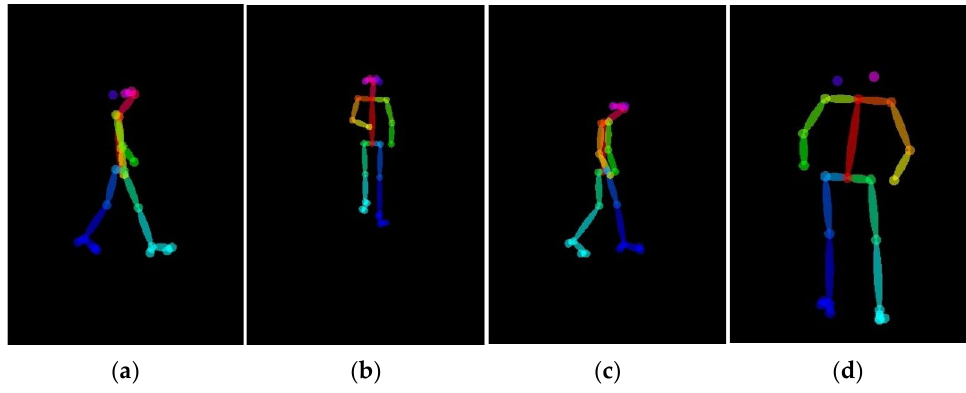
Figure 6. The two points of view for 3D reconstruction of one subject from the control group (( a ): the subject walks from left to right; ( b ): the subject walks towards the camera) and one of the control patients (( c ): the subject walks from left to right; ( d ): the subject walks away from the camera).